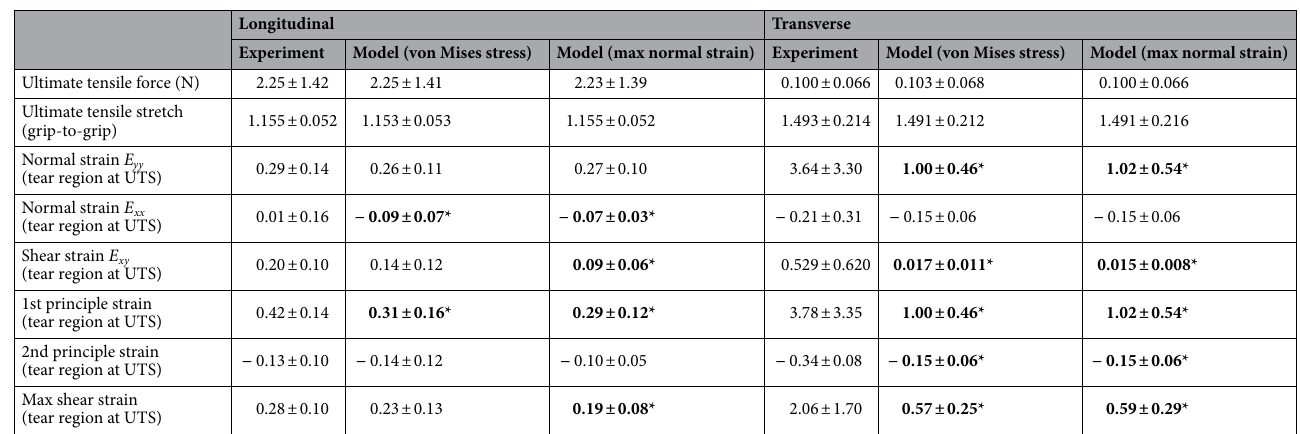
Table 2. Comparison of mechanical behavior between damage models and experiments (sample size for each cell = 20). All strain values are reported as Lagrange strain. Bolded values with an * are significantly lower than experimental data within either the Longitudinal or Transverse group ( p <